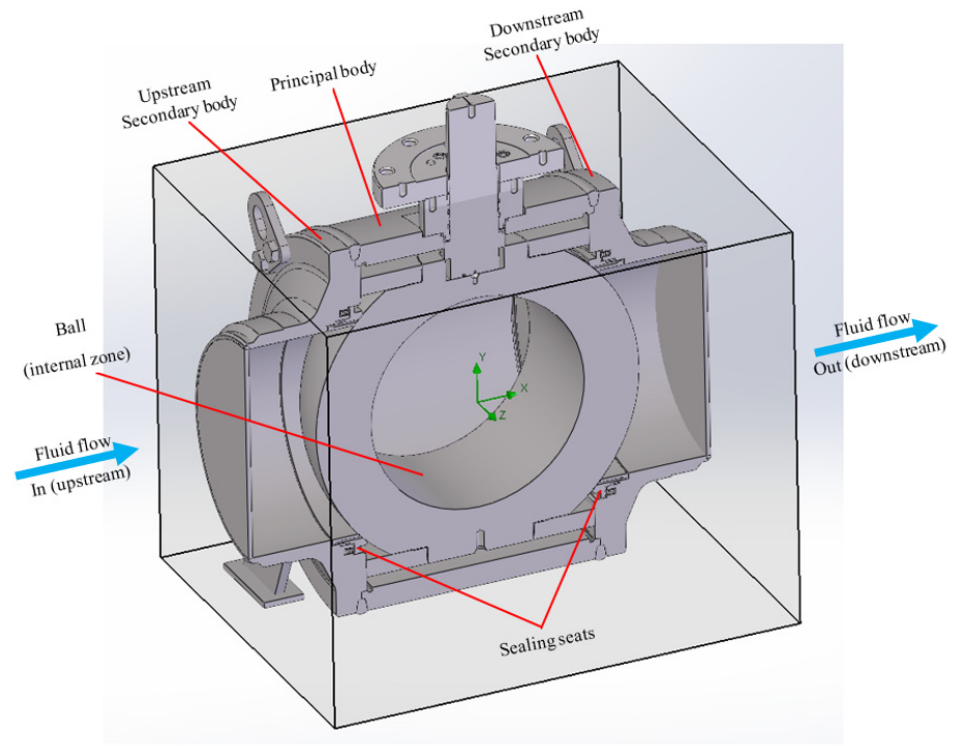
Figure 12. Computational domain of the ball valve in the 90° closure angle position.